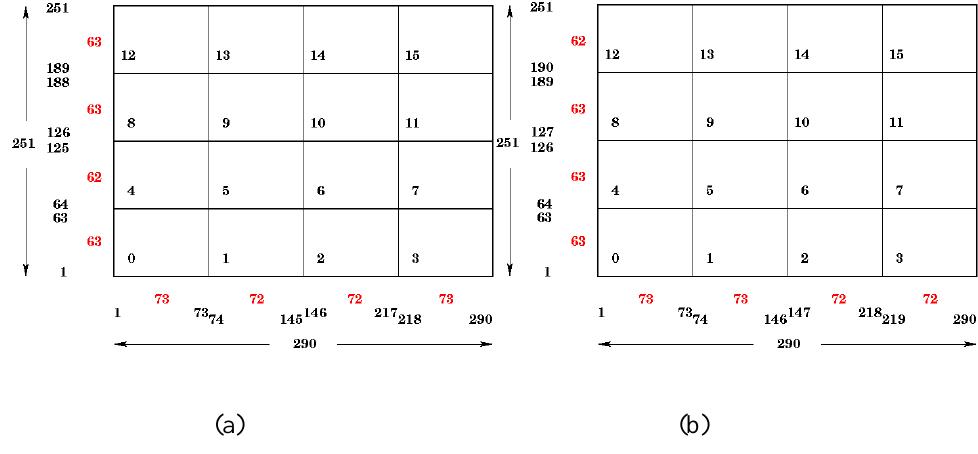
Figure 3. Decomposition with a 4x4 processor configuration for RSL-lite (a) and CMAQ (b). 4 Fig. 3. Decomposition with a 4 × 4 processor configuration for RSL-lite (a) and CMAQ (b)